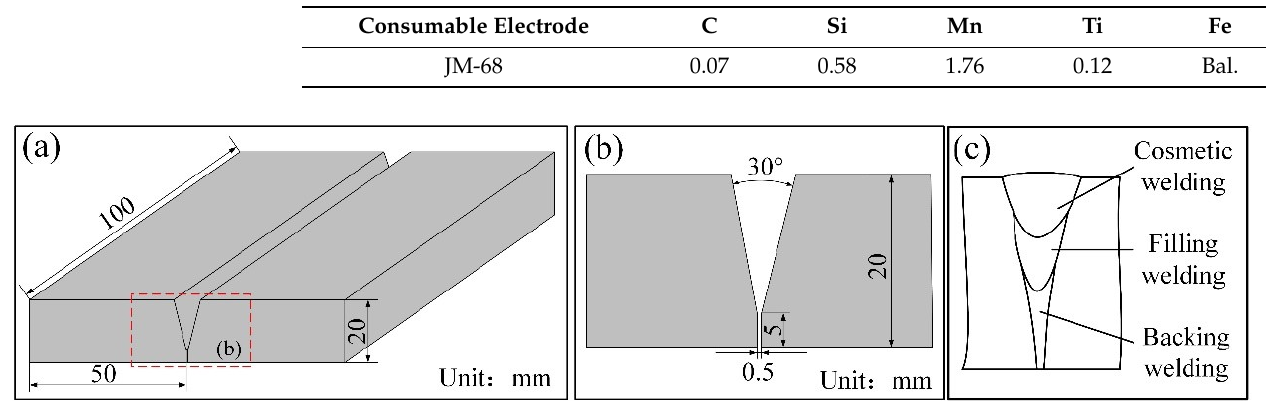
Table 1. Chemical composition of workpiece [Mass fraction/%].